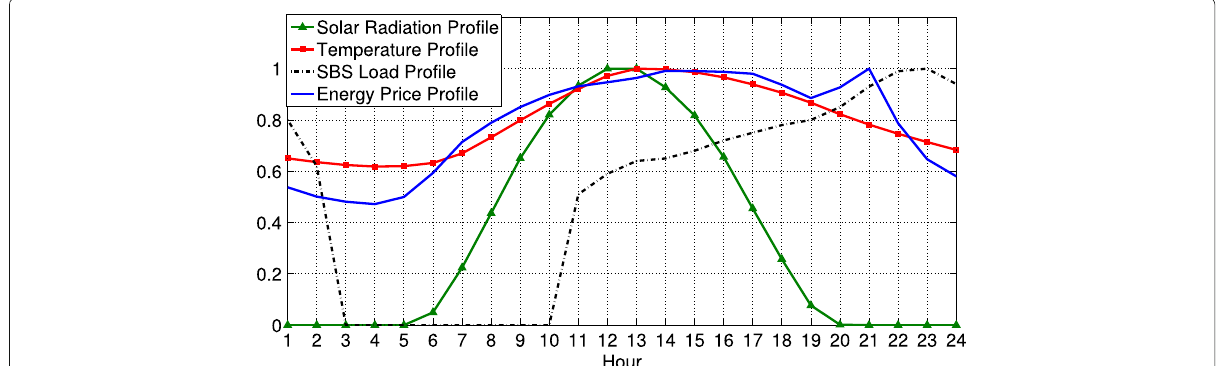
Fig. 4 Normalized profiles of the average solar radiation, average ambient temperature [31], SBS load (based on [36]), and average energy price